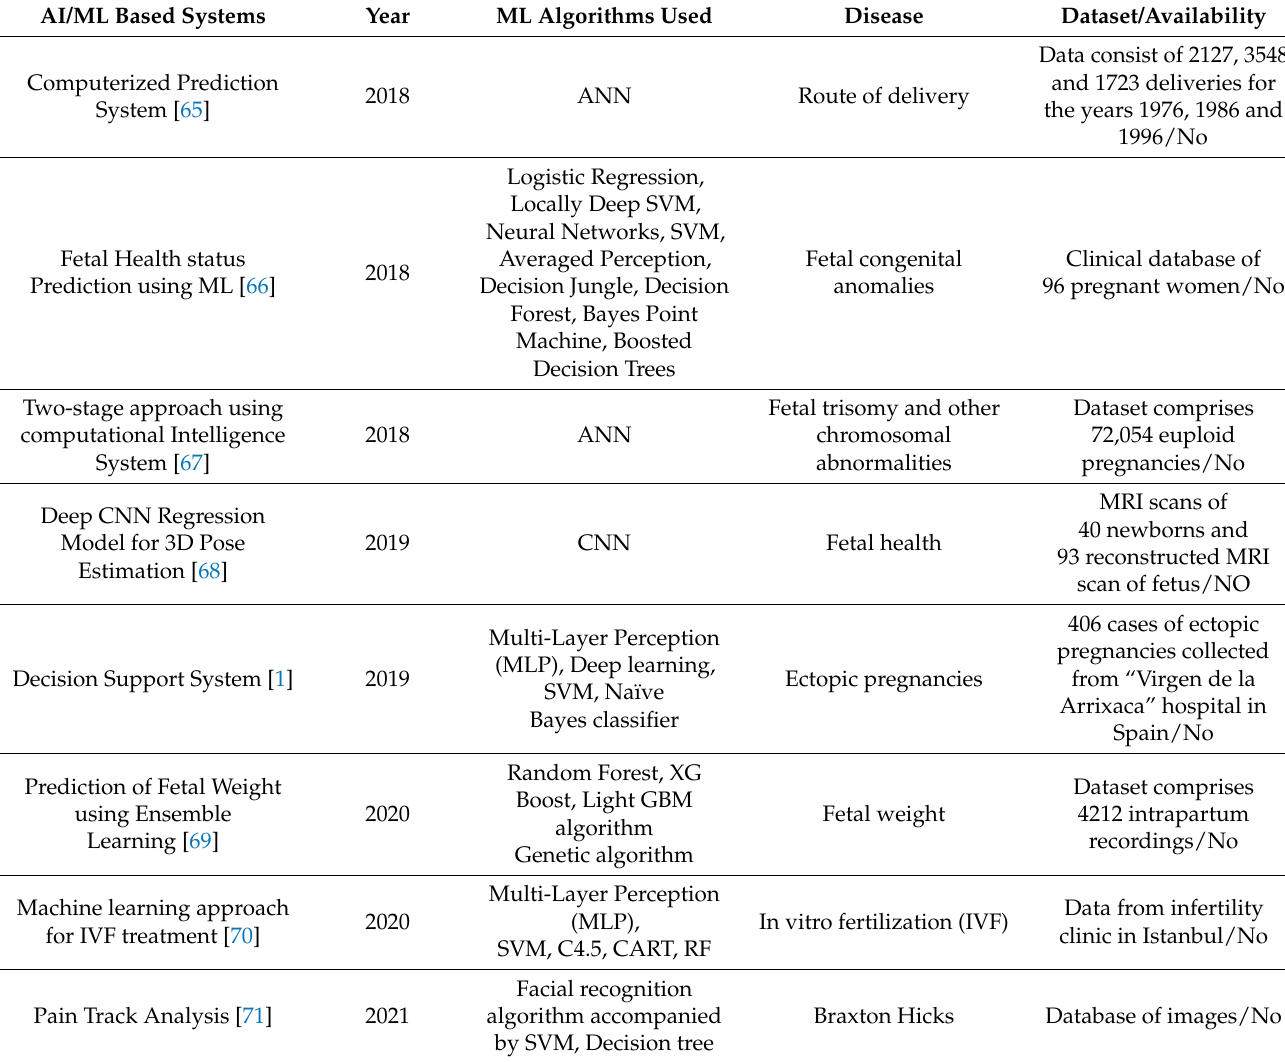
Table 3. Summary of AI/ML techniques used in maternal healthcare